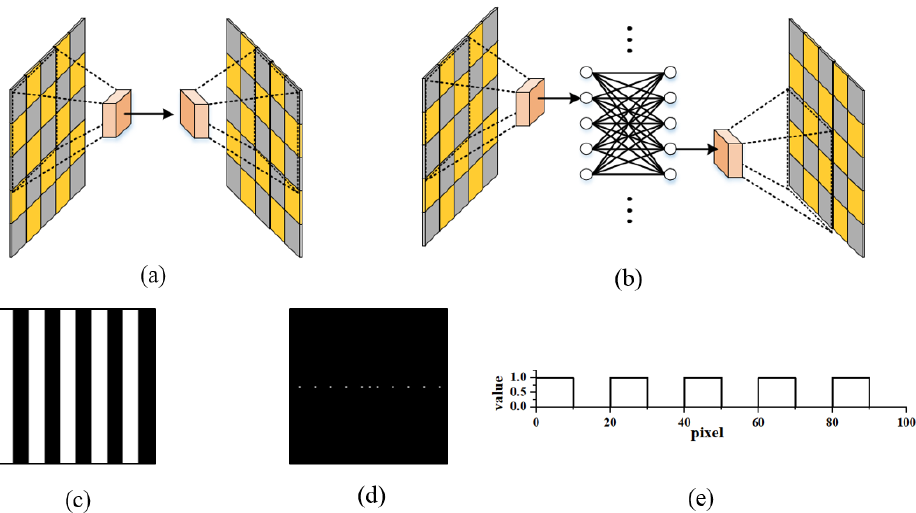
Figure 3. Advantages of MLCNN structure with linear cross layer. ( a ) Without linear layer structure; ( b ) with linear layer structure; ( c ) fringe image; ( d ) fast Fourier transform result; ( e ) numerical distribution.